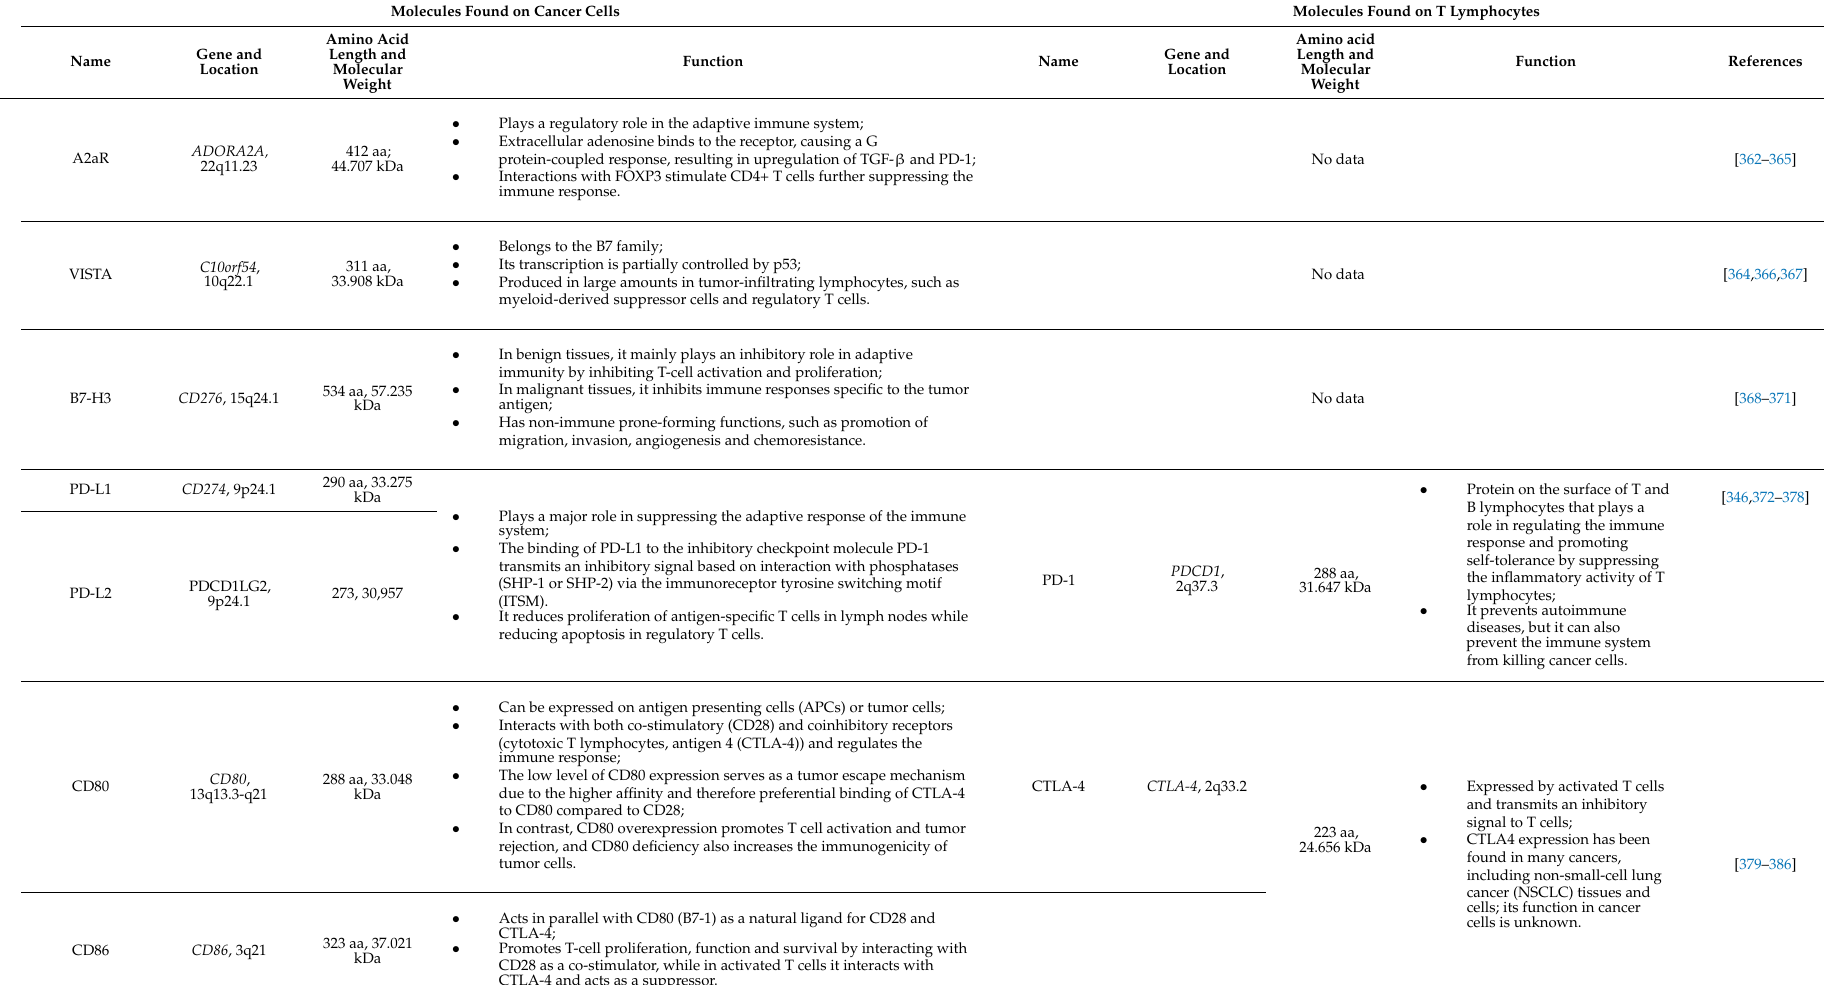
Table 4. Immune checkpoints considered in lung cancer